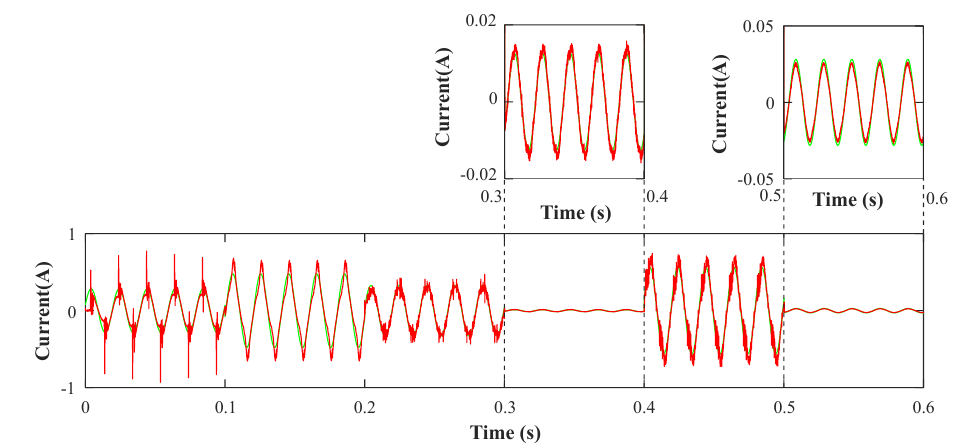
Figure 11. Input signal after filtration using the LMS algorithm; filter length 10, step size 0.005, delay 100 µ s.